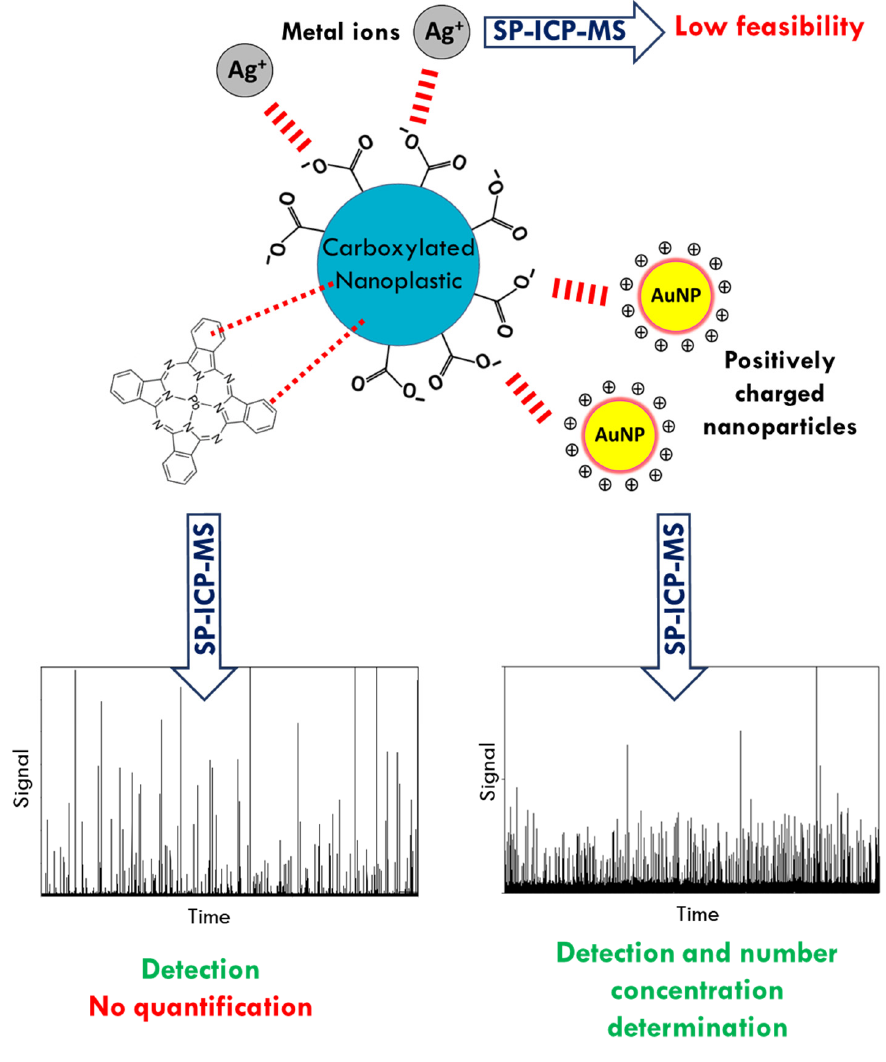
Figure 7. Summary of the different labelling strategies.